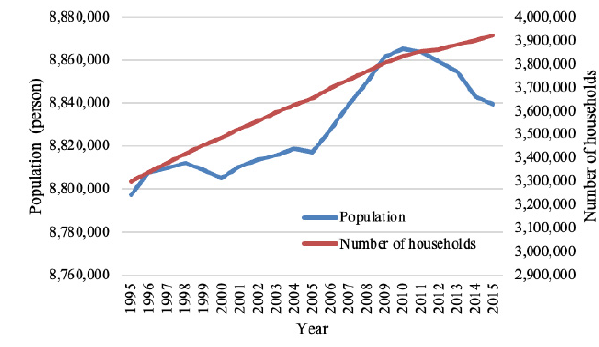
Figure 4 . Trends of the population and the number of households in the study area (Osaka Prefecture, 2019).